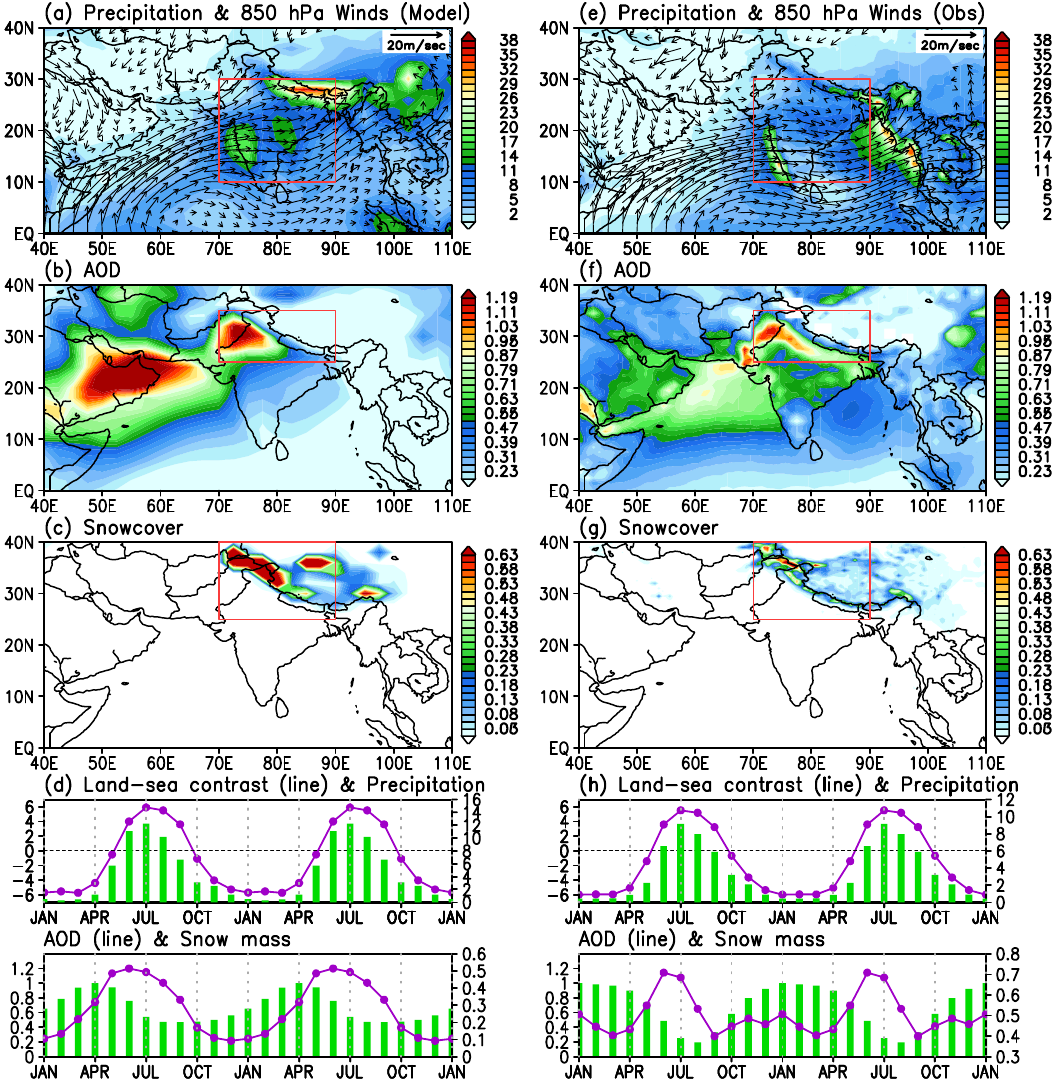
Figure 1. Model June–July–August mean climatology of the control experiment (snow darkening effect (SDE)) for ( a ) precipitation (mm day − 1 ) and 850 hPa winds (m s − 1 ), ( b ) aerosol optical depth (AOD), ( c ) snow cover fraction, and ( d ) seasonal cycle of land–sea contrast ( ◦ C), precipitation (mm day − 1 ), AOD, and snow mass, averaged over respective rectangular domains shown in ( a – c ), respectively. Land–sea contrast is computed as the temperature difference in the upper troposphere (500–200 hPa), between the northern [70–90 ◦ E, 20–30 ◦ N] and southern domain [70–90 ◦ E, 5 ◦ S–5 ◦ N]. Panels ( e – h ) are the same as ( a – d ), except from observations, that is, rainfall (Tropical Rainfall Measuring Mission (TRMM)), winds and temperature (Modern Era Retrospective-analysis for Research and Application, Version 2 (MERRA-2)), AOD, and snow mass (MODerate-resolution Imaging Spectroradiometer (MODIS)) in normalized